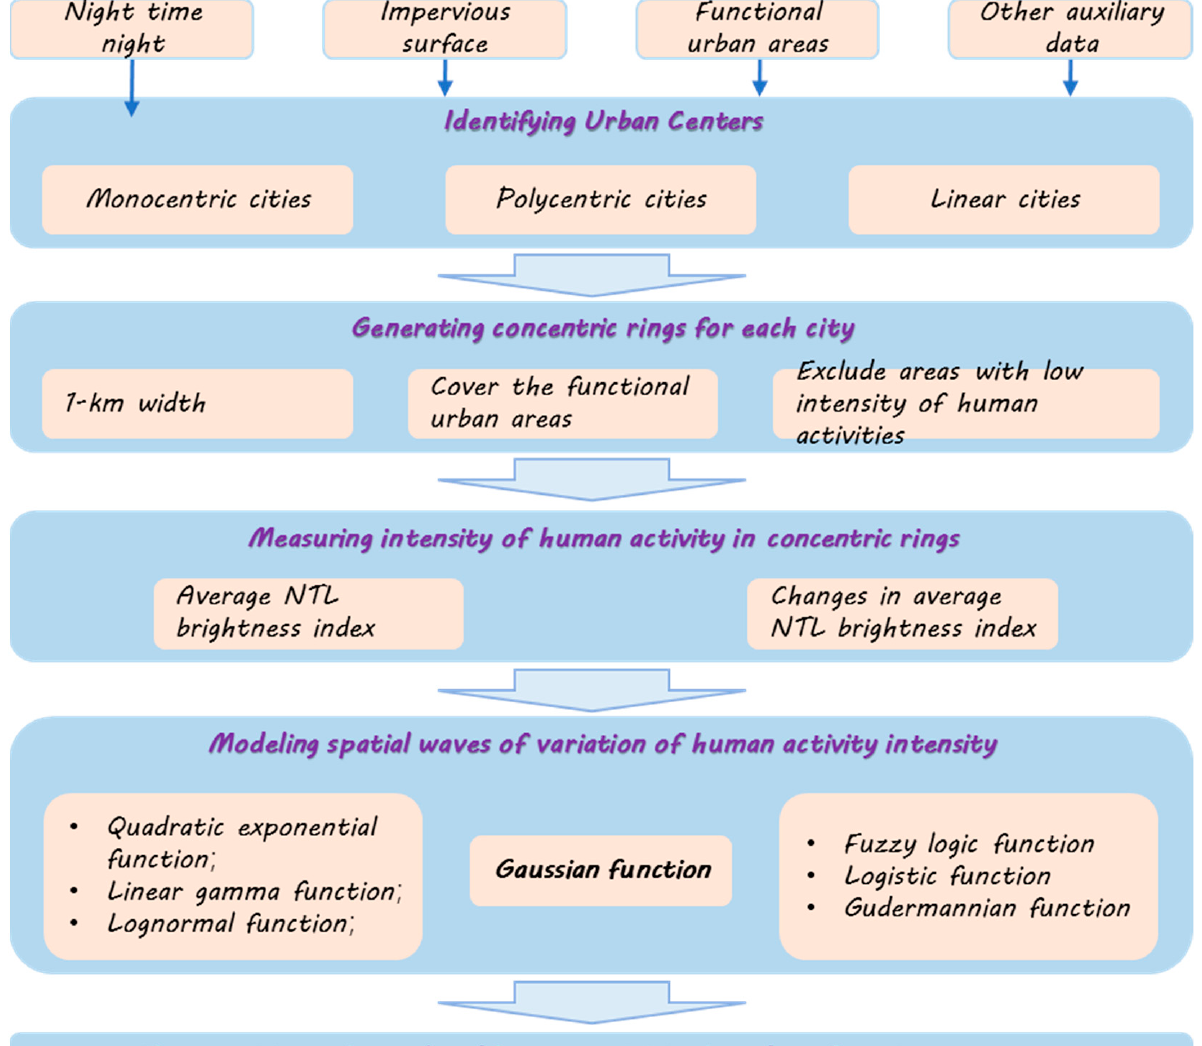
Figure 2. Overview of the technique flow in this study.